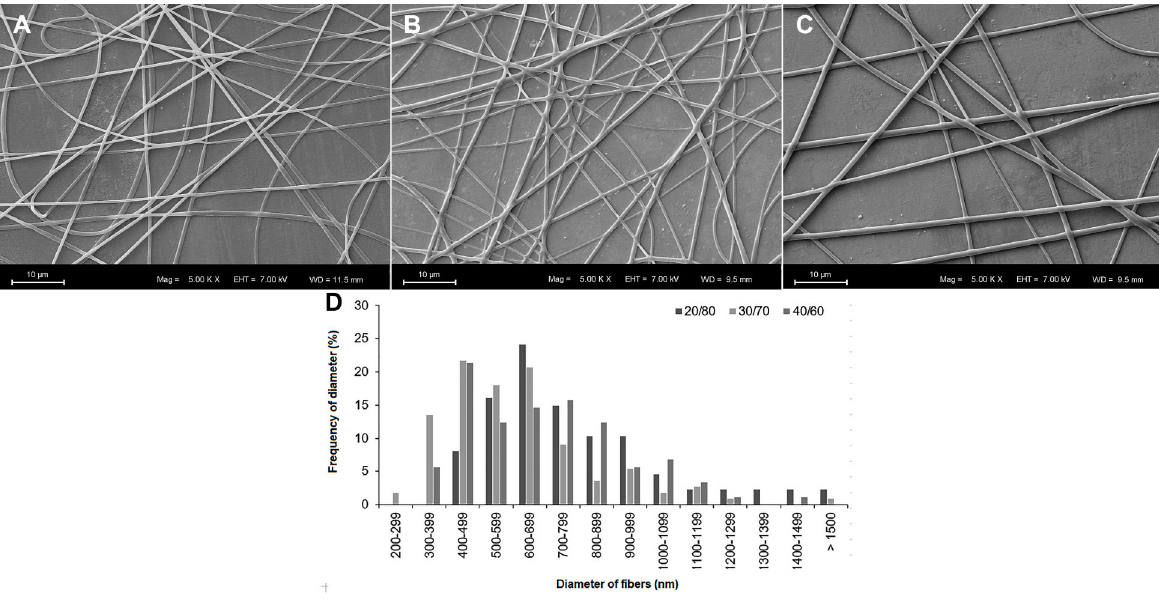
Figure 1. Scanning electron microscopy images of poly(trimethylene carbonate- co -L-lactide) (PTMCLLA) 20/80 ( A ), 30/70 ( B ), and 40/ 60 ( C ) (magni fi cation (cid:1) 5000, scale bars 10 m m). D , Distribution of diameter of fi bers in the PLLATMC 20/80, 30/70, and 40/60